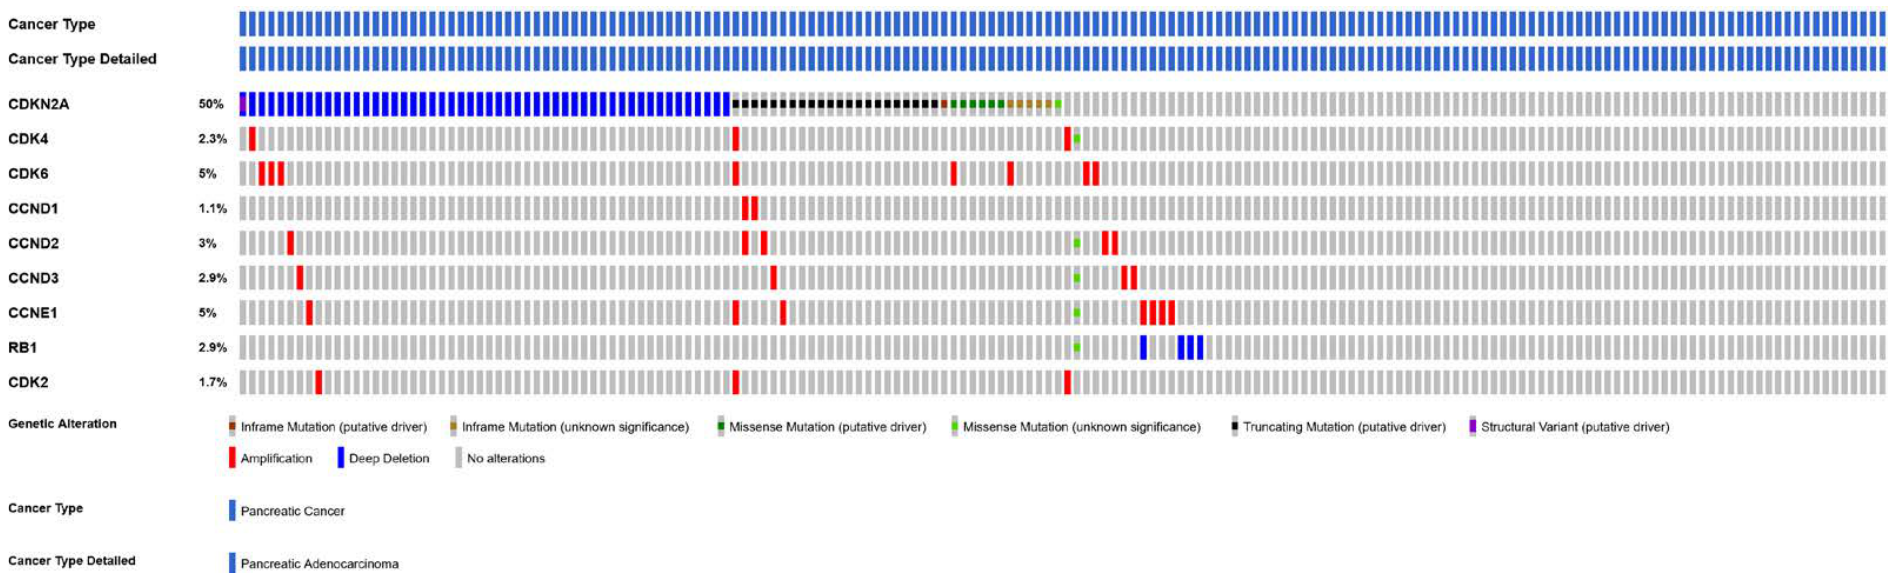
Figure 5. Oncoprint of the RB pathway genomic alterations in PDAC, showing mutations and copy number alterations (TCGA).